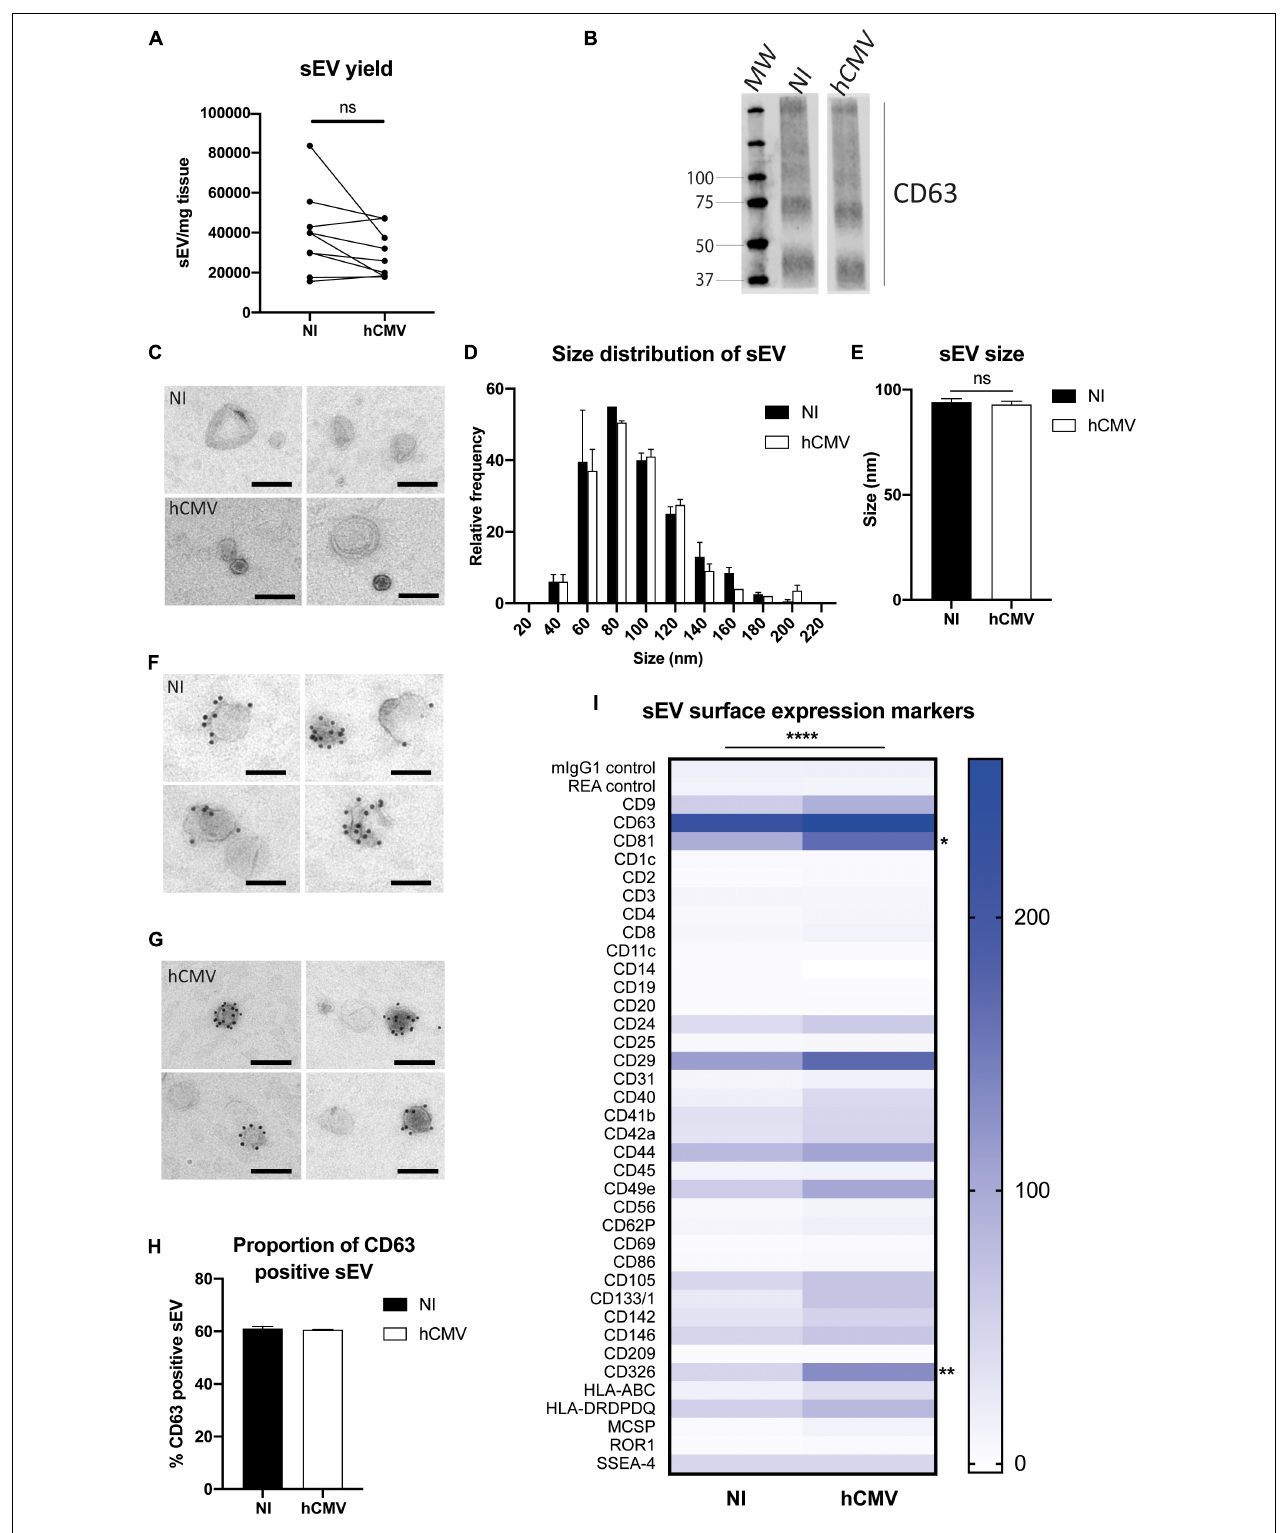
FIGURE 6 | Placental sEV isolation and characterization upon hCMV infection. (A) Comparison of the yield of sEV prepared per mg of placental tissue upon sEV preparation between non-infected (NI) versus hCMV-infected placental explants. Yield is expressed in sEV number/mg tissue, obtained from nine independent experiments. ns, non-significant by Wilcoxon paired test. (B) Western blot analysis against CD63 in sEVs prepared from non-infected (NI) or infected (hCMV) placental explants. This result is representative for at least three independent experiments. CD63 appears as a smear since the non-reducing conditions of